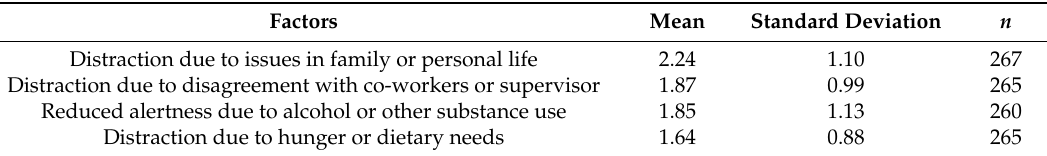
Table 5. Survey respondents’ evaluation of how common it is for select social and behavioral factors to contribute to injury incidents on logging operations in the Inland Northwest, average of 1 to 5 scale (1 = not at all common, 5 = very common). Factors Mean Standard Deviation n Distraction due to issues in family or personal life 2.24 1.10 267 Distraction due to disagreement with co-workers or supervisor 1.87 0.99 265 Reduced alertness due to alcohol or other substance use 1.85 1.13 260 Distraction due to hunger or dietary needs 1.64 0.88